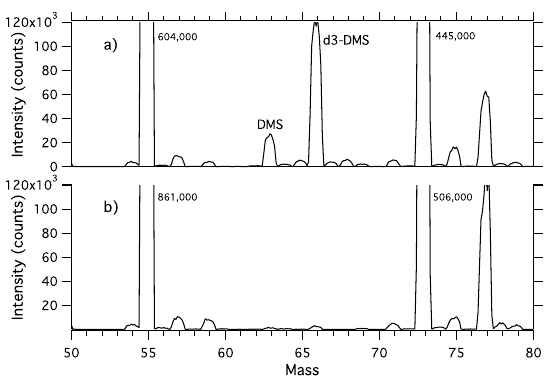
Fig. 2. Raw signals (counts s − 1 ) for ambient DMS and internal standard (masses 63 and 66, respectively). The gold bead DMS trap was activated shortly after 2300h, illustrating the response time and background signal